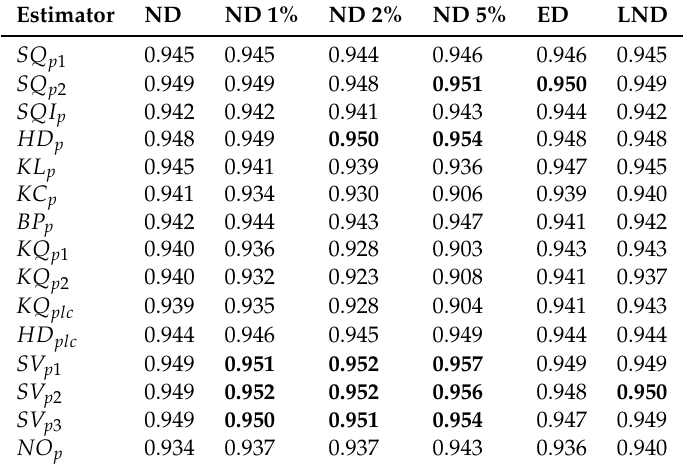
Table 5. Coverage probabilities for nonparametric Limits of Agreement ( n = 150). Bold figures indicate coverage probabilities exceeding the nominal level of